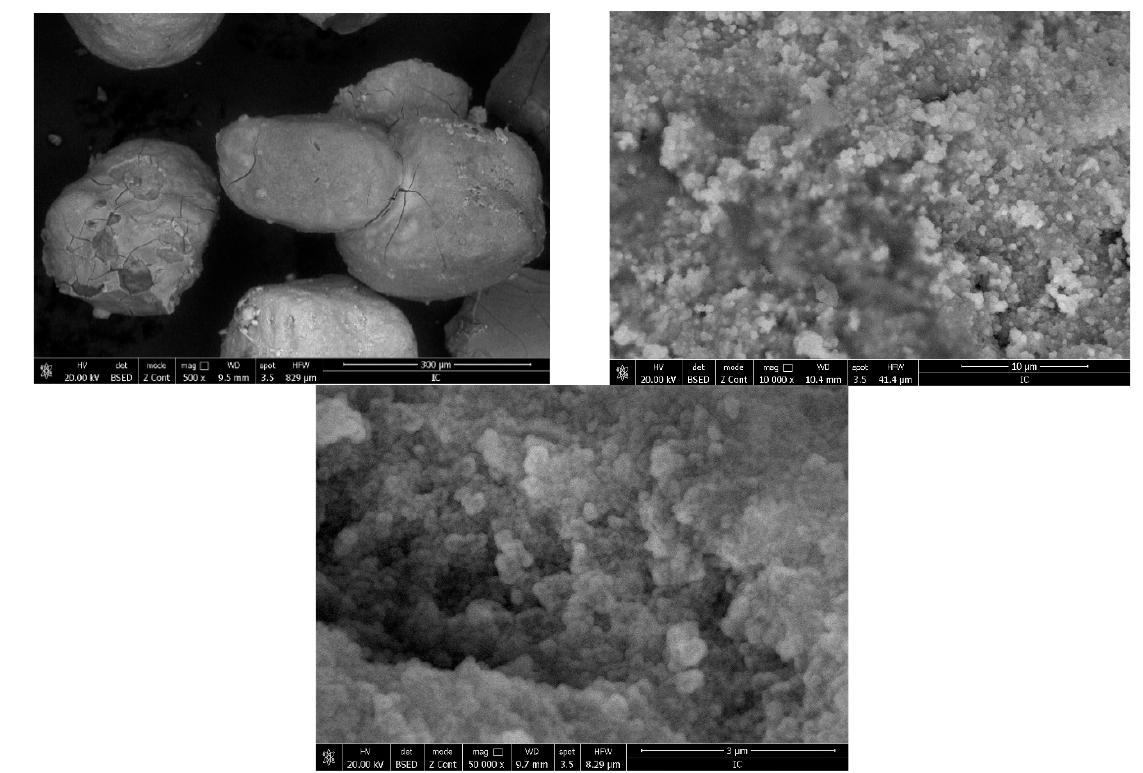
Figure 3. Scanning electron microscope images of sample BCb/CB (500× left ; 10,000× right , 50,000× second line ).